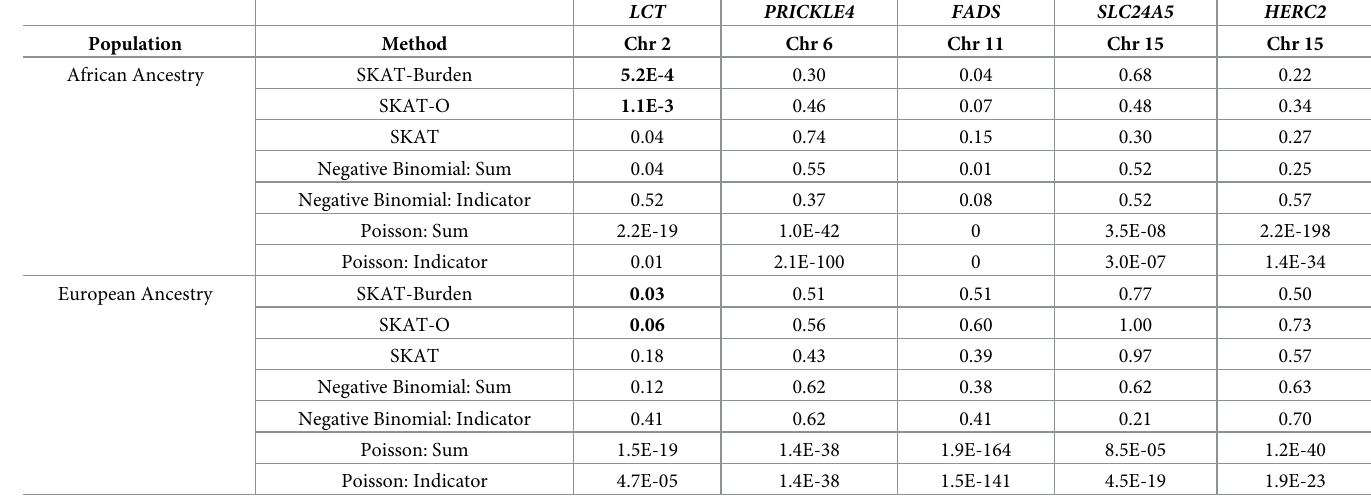
Table 1. Using the total read counts for each of the 87 Yoruba subjects with African Ancestry and 266 subjects with European ancestry from the 1000 genomes proj- ect, we applied the 7 approaches to determine if the rare variants in these genes are associated with the overall expression levels for these genes. Below are the p-val- ues for all approaches and 5 genes ( LCT , PRICKLE4 , FADS , SLC24A5 , HERC2 ). Sum refers to the sum of the rare variants in the region and Indicator refers to the indicator function which equals one if the subject has at least one rare variant in the region.